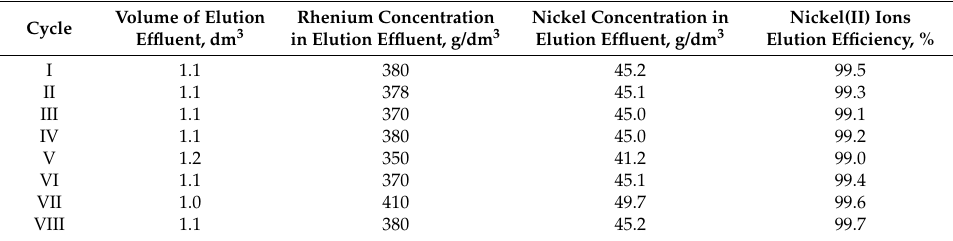
Table 4. Nickel(II) ions elution results—eight cycles after the regeneration. Cycle